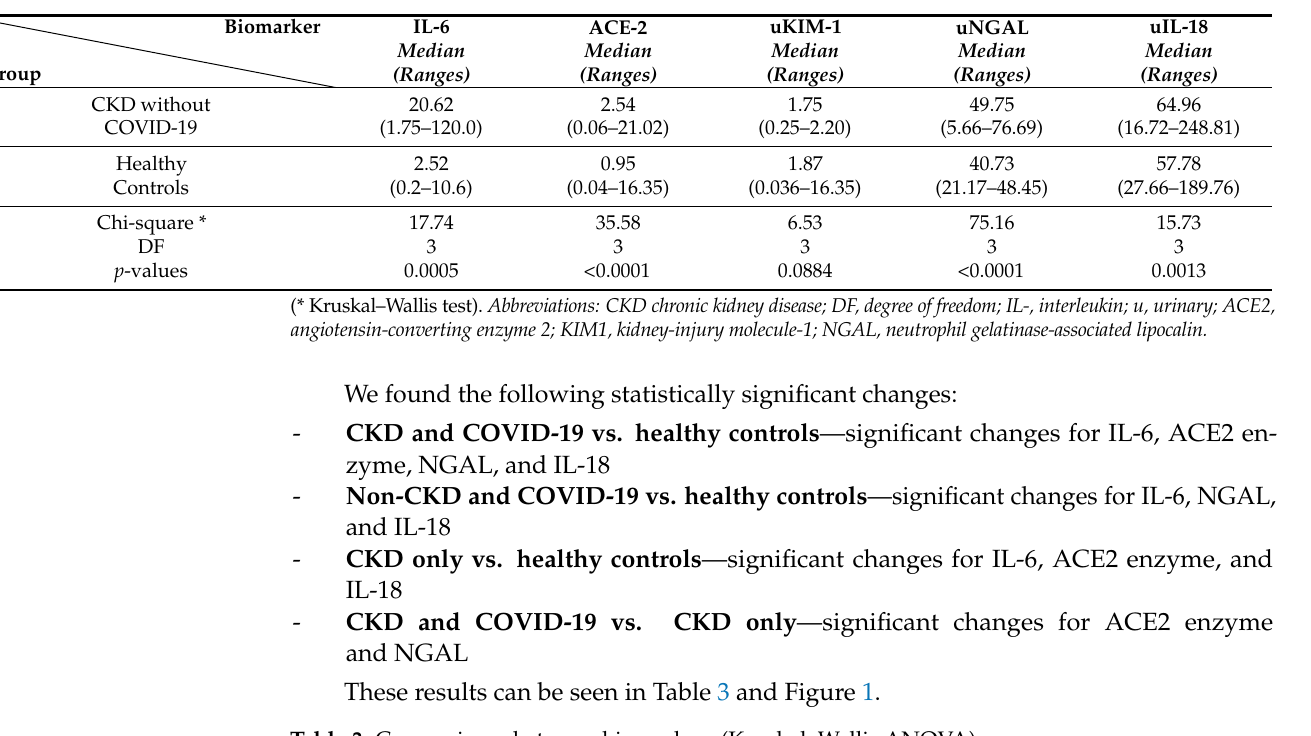
Table 3. Comparisons between biomarkers (Kruskal–Wallis